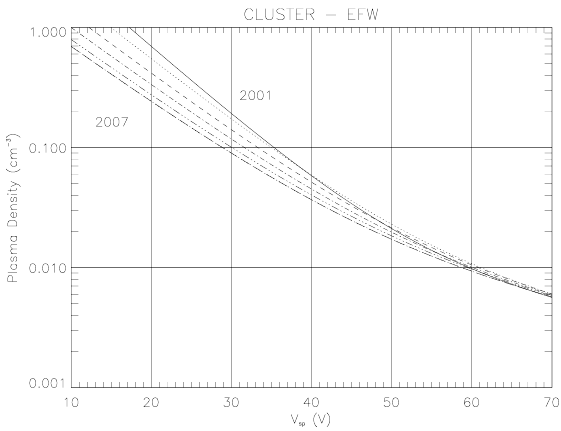
Fig. 1. This figure shows the relationship between the ambient plasma density and V sp , the measured spacecraft to probe potential difference as given by Eq. (1). The various curves are obtained by using the coefficients given in Table 1. The differences between the curves are due to the diminishing photo-electric current throughout the waning phase of the solar